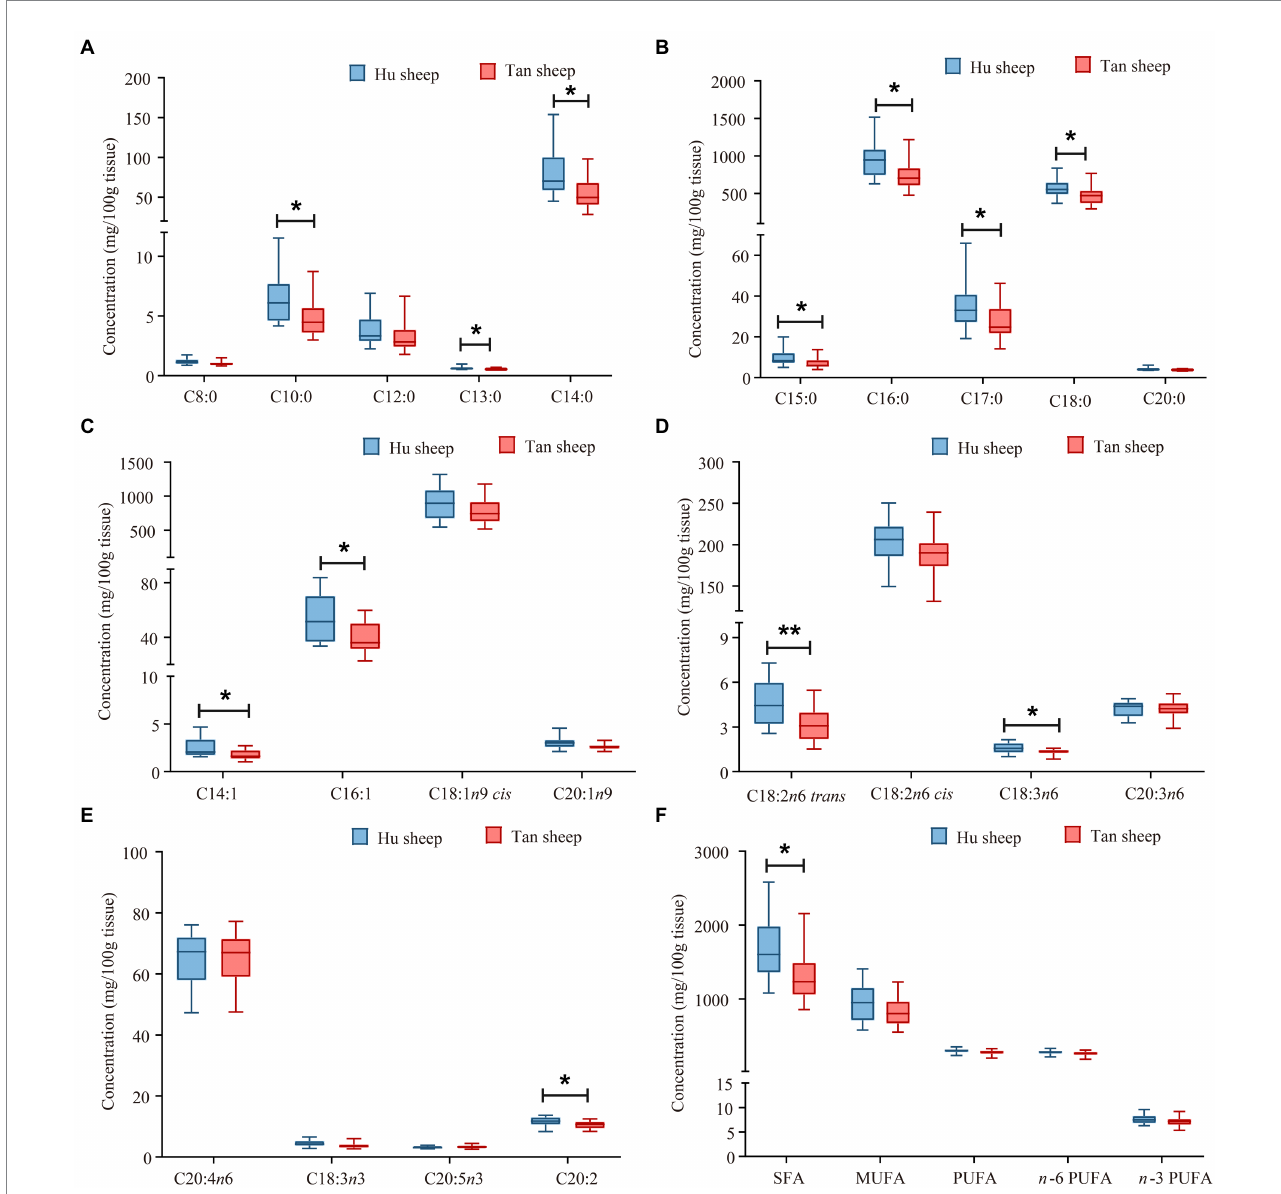
FIGURE 2 Fatty acid profiles of psoas major muscles from Hu and Tan sheep ( n = 20). C8:0, caprylic acid; C10:0, capric acid; C12:0, lauric acid; C13:0, tridecanoic acid; C14:0, myristic acid; C15:0, pentadecanoic acid; C16:0, hexadacanoic acid; C17:0, heptadecanoic acid; C18:0, octadecanoic acid; C20:0, arachidic acid; C14:1, myristoleic acid; C16:1, palmitoleic acid; C18:1 n 9 cis, oleic acid; C20:1 n 9 cis-11-eicosenoic acid; C18:2 n 6 trans, linolelaidic acid; C18:2 n 6 cis, linoleic acid; C18:3 n 6, γ -linolenic acid; C20:3 n 6, cis-8,11,14-eicosatrienoic acid; C20:4 n 6, arachidonic acid; C18:3 n 3, α -linolenic acid; C20:5 n 3, cis-5,8,11,14,17- eicosapentaenoic acid; C20:2, cis-11,14-eicosadienoic acid; SFA, total saturated fatty acids; MUFA, total monounsaturated fatty acids; PUFA, total polyunsaturated fatty acids, n -6 PUFA, total omega-6 polyunsaturated fatty acids; n -3 PUFA, total omega-3 polyunsaturated fatty acids. * p < 0.05 and ** p <